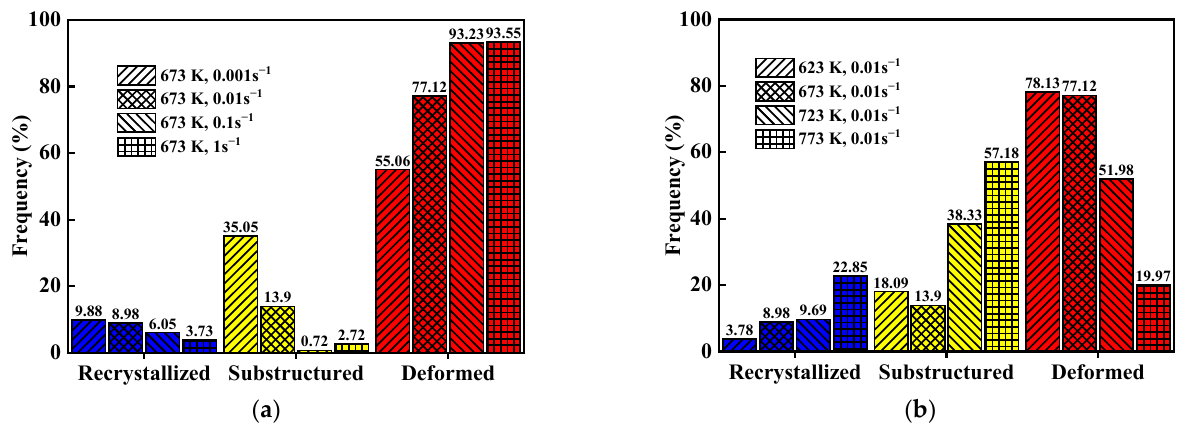
Figure 13. Comparison of recrystallized, substructured, and deformed grains under different hot working conditions ( a ) 0.001 s −1 , 0.01 s −1 , 0.1 s −1 , 1 s −1 under 673 K; ( b ) 623 K, 673 K, 723 K, 773 K under 0.01 s −1 .